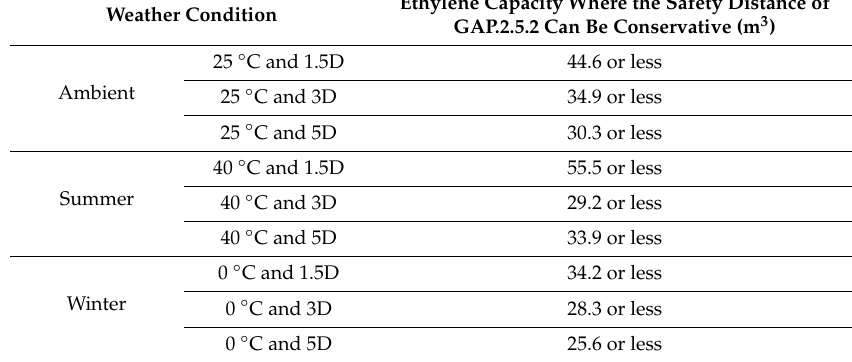
Table 9. Storage capacity of ethylene to satisfy the safety distance of GAP.2.5.2 according to atmospheric conditions.